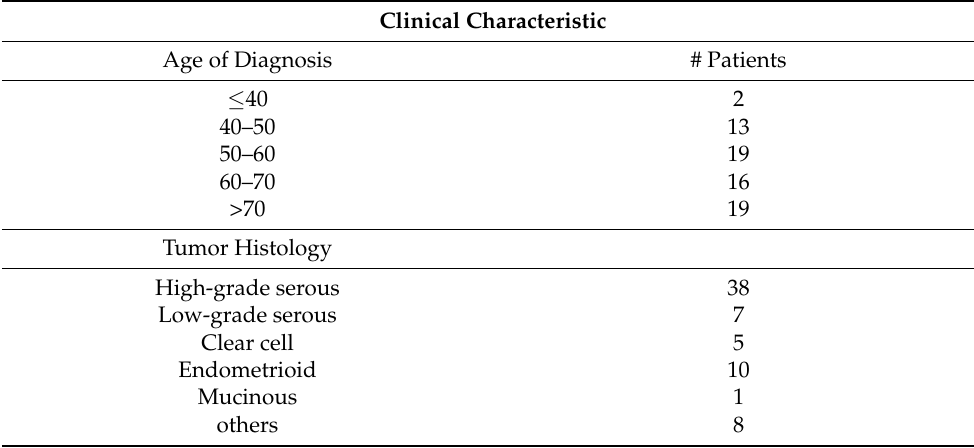
Table 1. Clinical and demographic characteristics of our